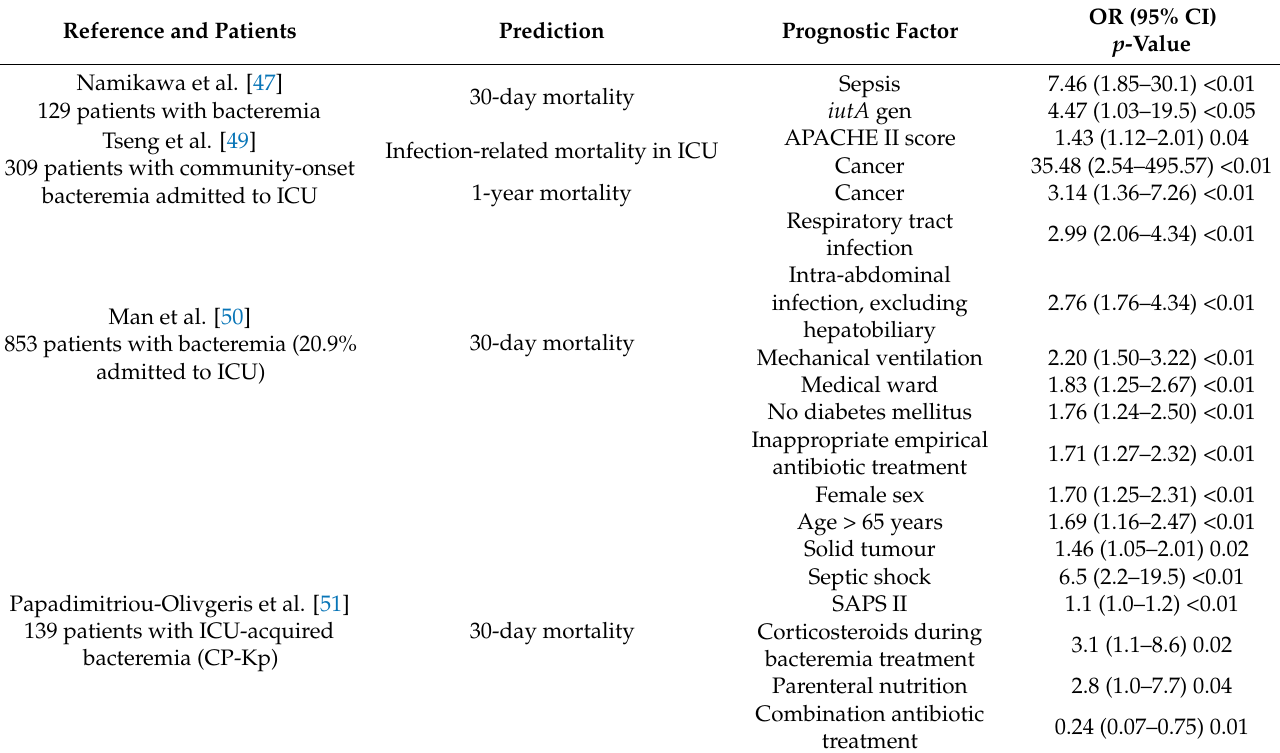
Table 2. Risk factors associated with mortality in K. pneumoniae infections.